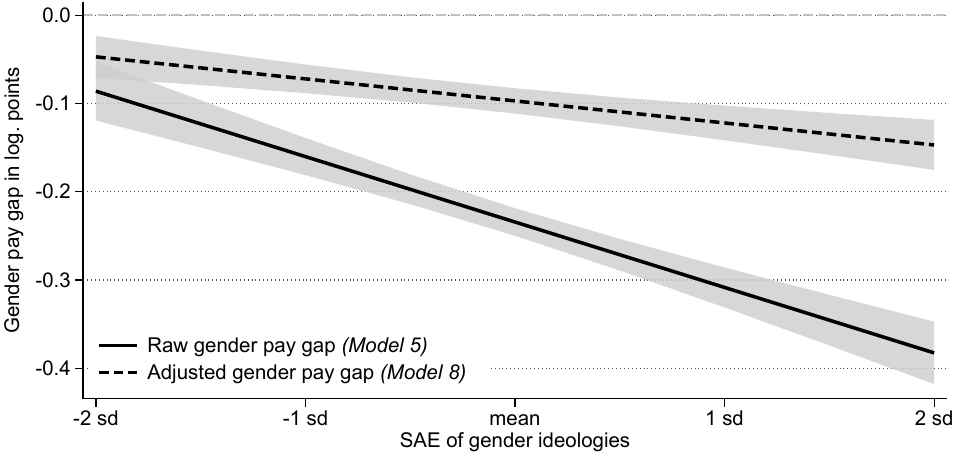
Figure 3. Predicted Gender Pay Gap by Gender Ideologies. Source: SOEP v35, own estimation, based on Table 2. Note: Shaded areas mark 95 percent confidence